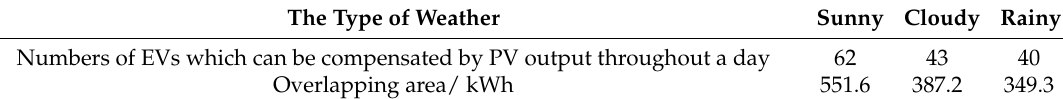
Table 1. Optimal quantity bounds of unconstrained EV charging using PVs for three weather types.